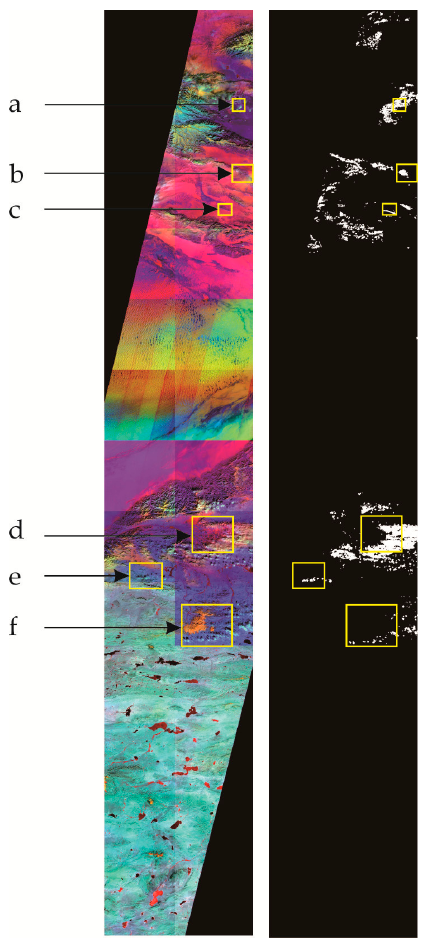
Figure 10. Proposed method results of 25 Sentinel-2 scenes. Composited images with bands 4, 10, and 11 in red, green and blue, respectively, are shown on the left, and cloud masks are shown on the right with white color (cropping 6 regions of interest).